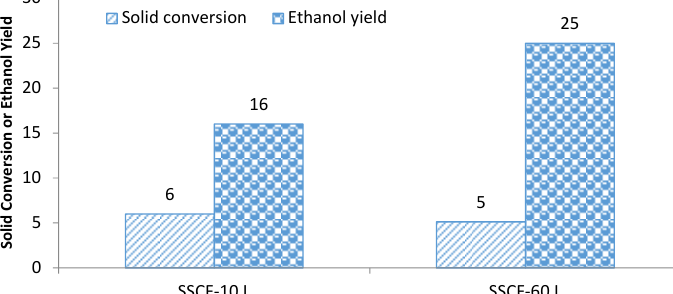
Figure 4. Solid conversion (%) and ethanol yield (kg/100 kg dry solids) from 10 L and 60 L enzymatic treatment and co-fermentation of IF with S. cerevisiae and E. coli KO11. Solid conversion = final dry biomass, kg × 100/initial biomass, kg as is.